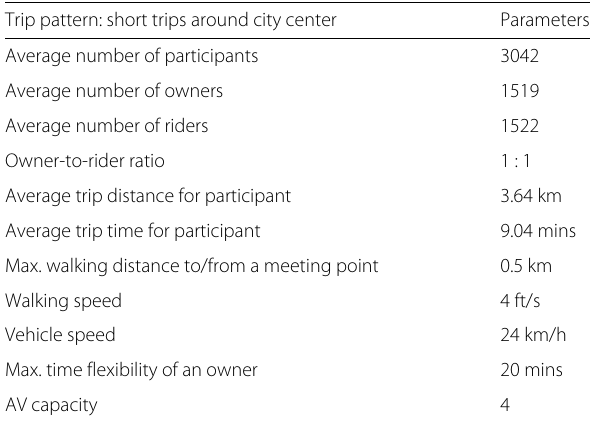
Table 1 Base case instance characteristics